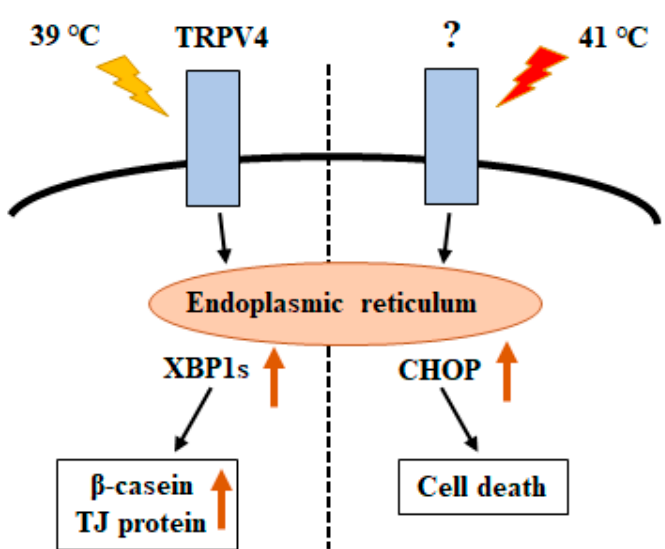
Figure 6. Schematic model showing unfolded protein response (UPR)-mediated crosstalk between temperature and cellular response.